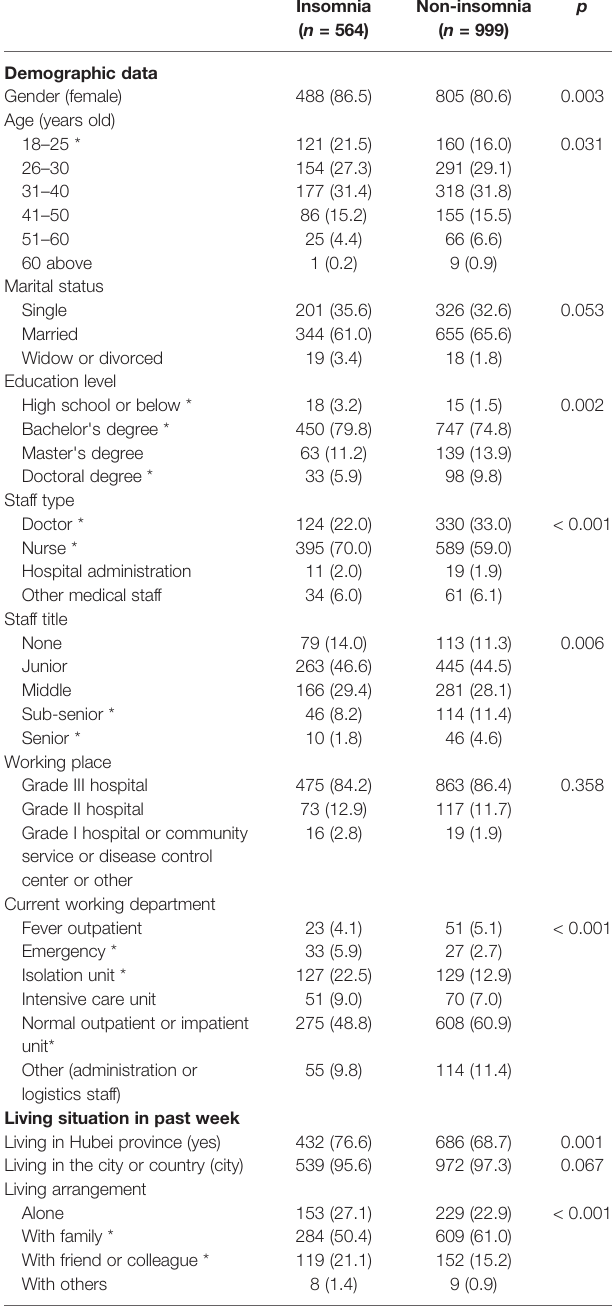
TABLE 1A | Comparisons between insomnia and non-insomnia individuals used chi-square tests on demographic data and living situations. Insomnia ( n =